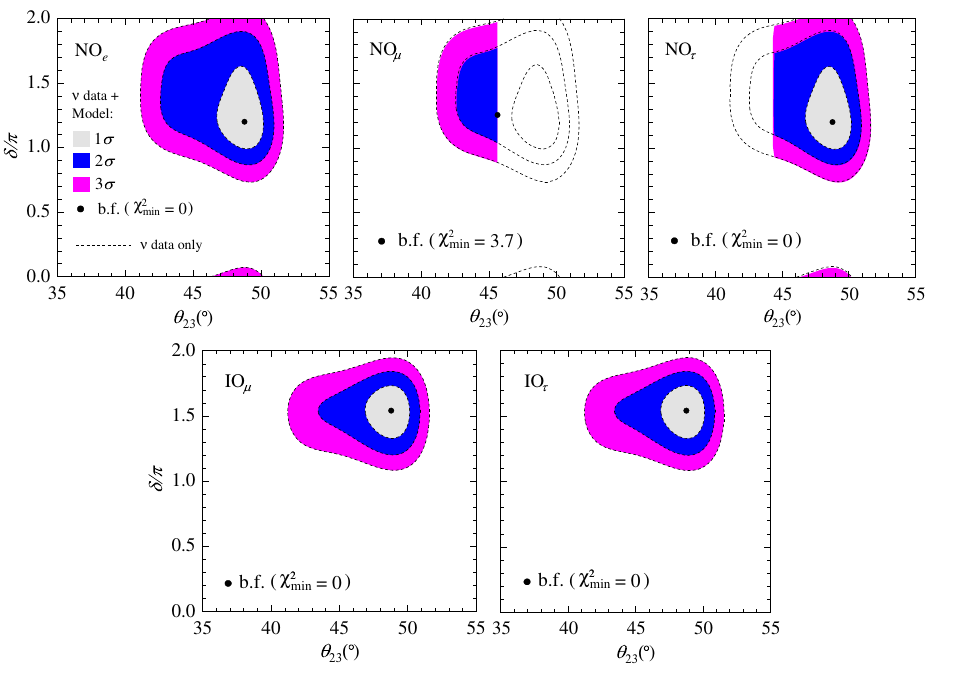
Figure 5 . Allowed regions in the plane ( θ 23 , δ ) for NO e,µ,τ (upper plots) and IO µ,τ (lower plots) for the Z model considered. As discussed in the text the IO 8 lines delimit the allowed regions obtained considering only neutrino oscillation data, i.e. without input of the